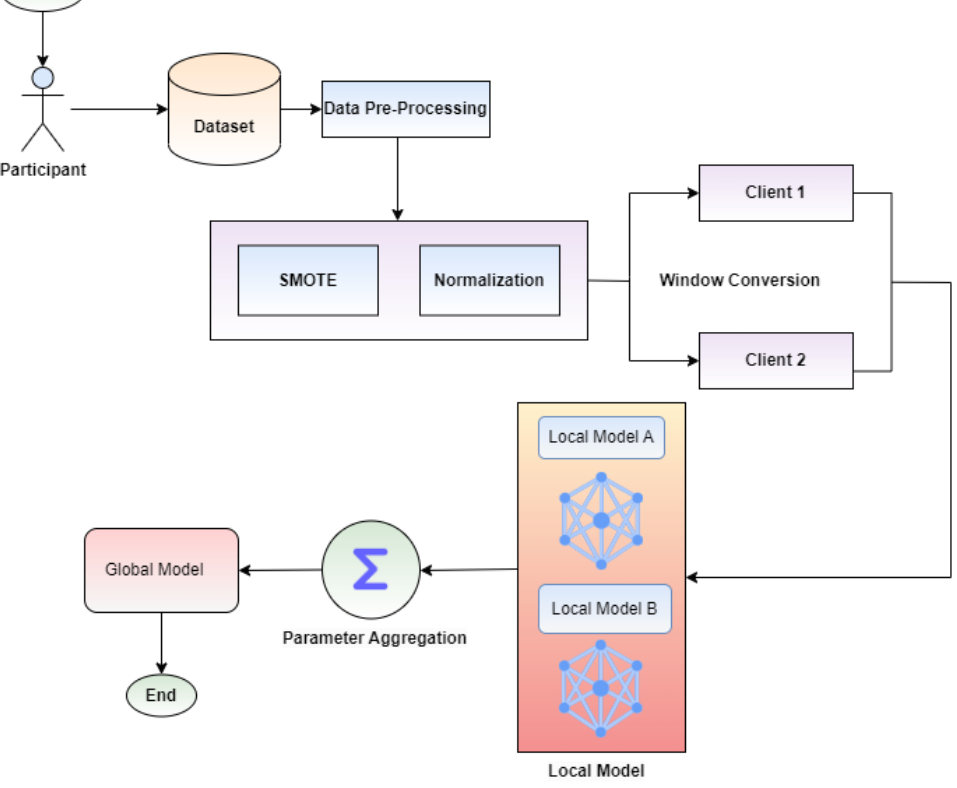
Figure 1. Proposed federated learning framework